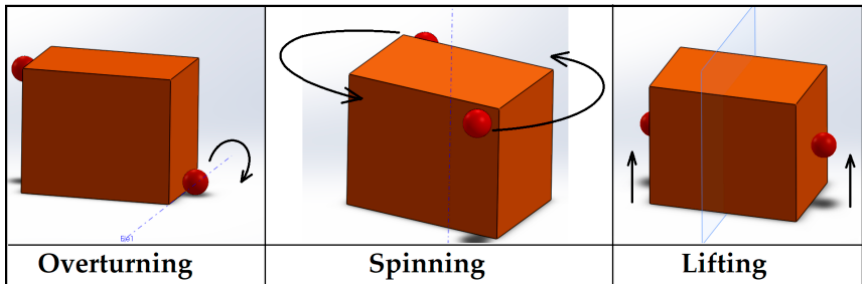
Figure 2. Classification of movements involved in bi-manipulating a box.